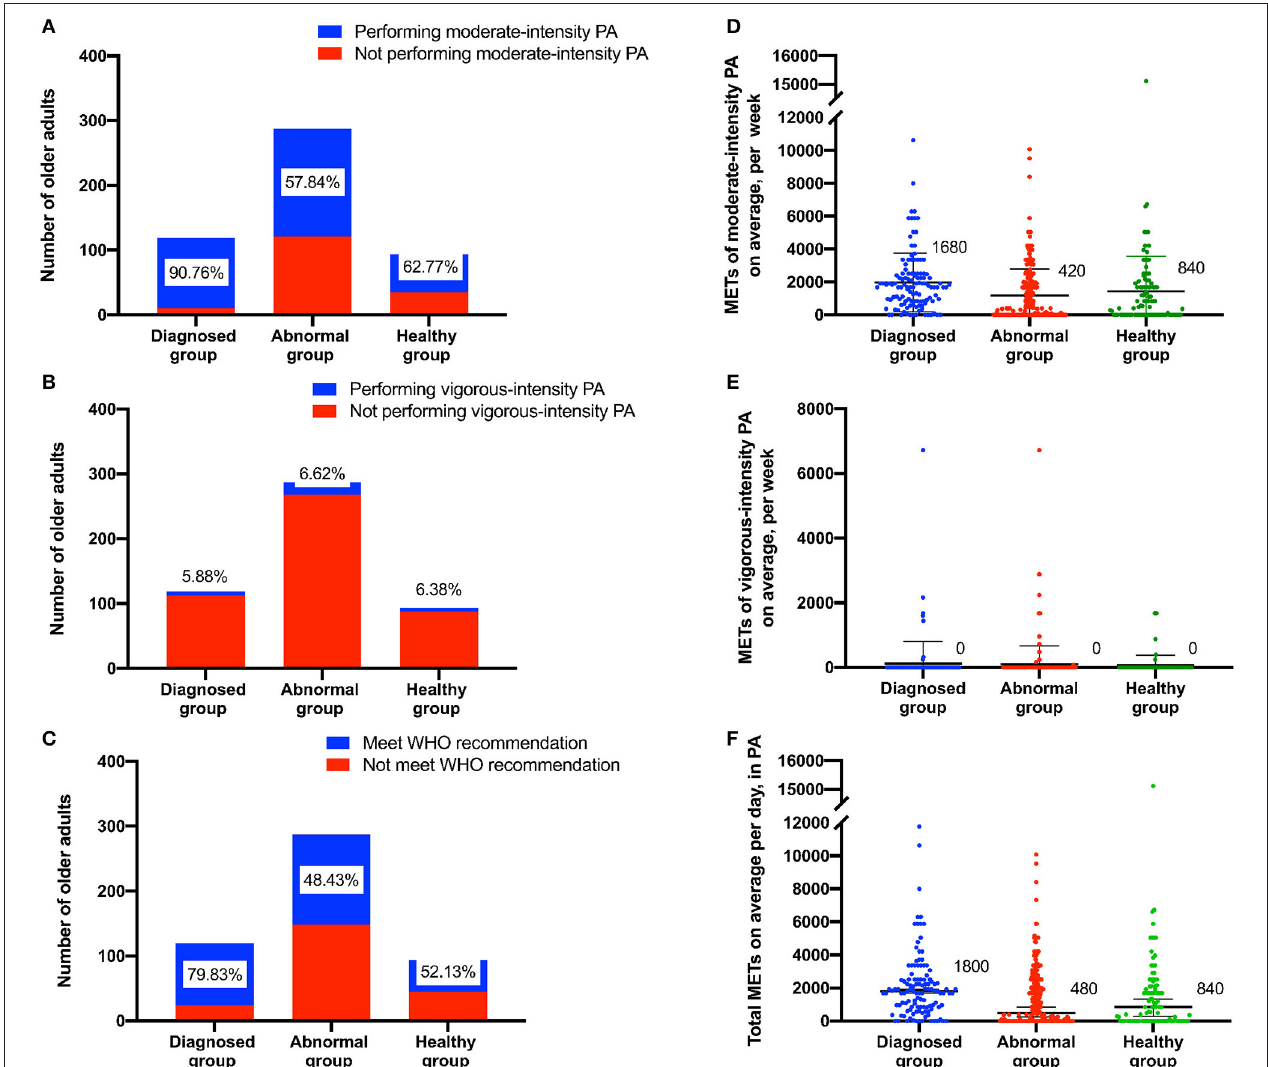
FIGURE 2 | Elderly individuals performing moderate- or vigorous-intensity PA in the three health status groups. (A,B) count the number and proportion of older adults participating in the different intensity of PA. (C) counts the number and proportion of older adults who met the WHO’s recommended level. (D) shows the METs of moderate-intensity PA. (E) shows the METs of vigorous-intensity PA. (F) shows the total